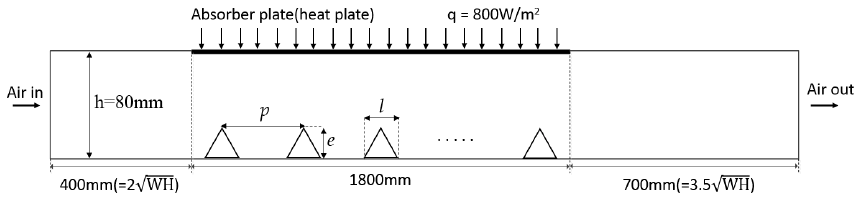
Figure 1. Schematics of the solar air heater with a transverse triangular block at the bottom of air duct.